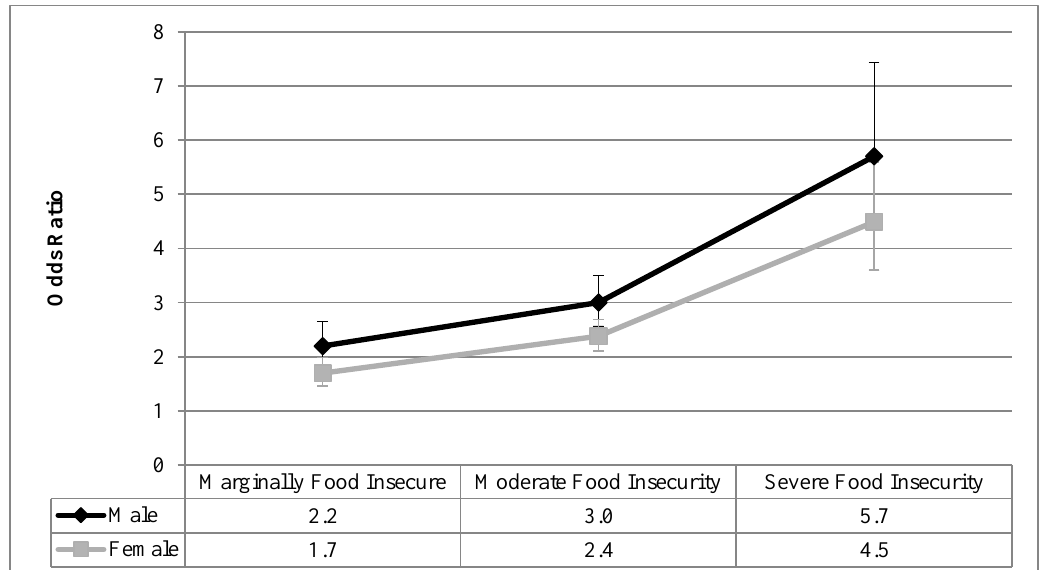
Figure 1. Odds ratio of reporting depressive thoughts in the past month for each level of household food insecurity stratified by sex, compared with food secure; results from reduced binary logistic regression.